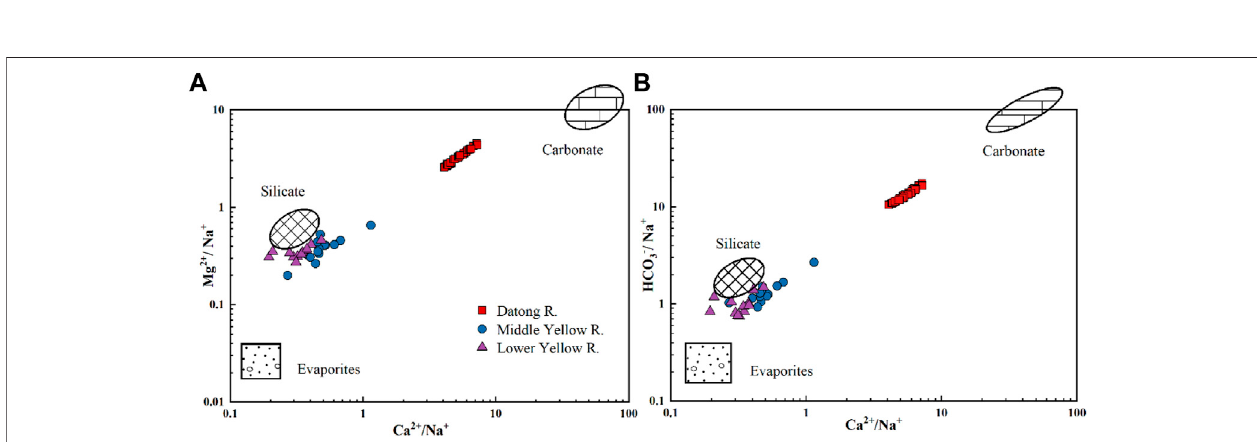
FIGURE 6 | Plot of Ca 2+ +Mg 2+ versus HCO 3 − and Si 4+ /Na + versus Ca 2+ +Na + of river water in the Datong River. The data suggest potential carbonate and silicate weathering in the Datong River catchment.